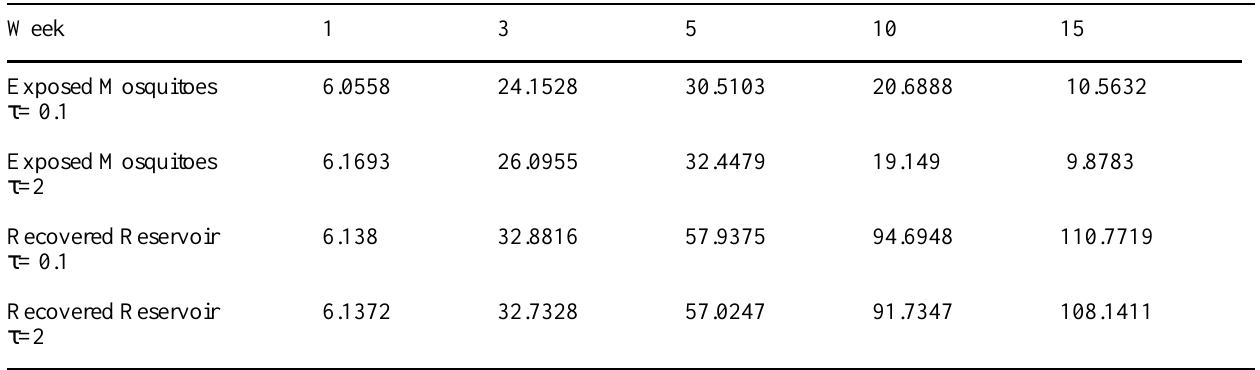
Table 4. Numerically simulated model values for exposed mosquitoes and recovered reservoirs for two different values of virus incubation delay lengths (? = 0.1 and ? = 2 weeks). Both populations are decreasing as a function of virus incubation length, indicating a faster convergence to the disease-free equilibrium. Week 1 3 5 10 15 Exposed Mosquitoes 6.0558 24.1528 30.5103 10.5632 t = 0.1 Exposed Mosquitoes 6.1693 t =2 Recovered Reservoir 6.138 t = 0.1 Recovered Reservoir t =2